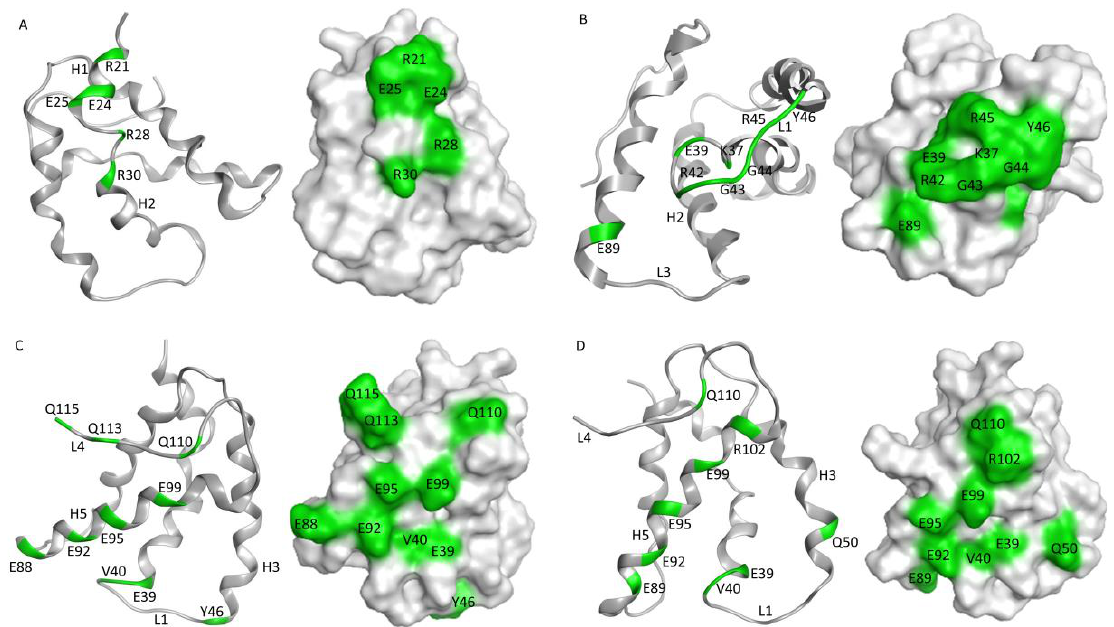
Figure 8. Predicted epitopes for anti-Ana o 3 monoclonal antibodies. Anti-Ana o 3 monoclonal antibody epitopes were predicted using Molecular Operating Environment (CCG) software. Ribbon diagrams and surface exposure models highlighting amino acids in green that are predicted to be important for Ana o 3.0101 recognition by ( A ) 2H5, ( B ) 5B7F8, ( C ) 6B9C1, and ( D ) 19C9A2 antibodies with Ana o 3.0101 loops and helices numbered consecutively.